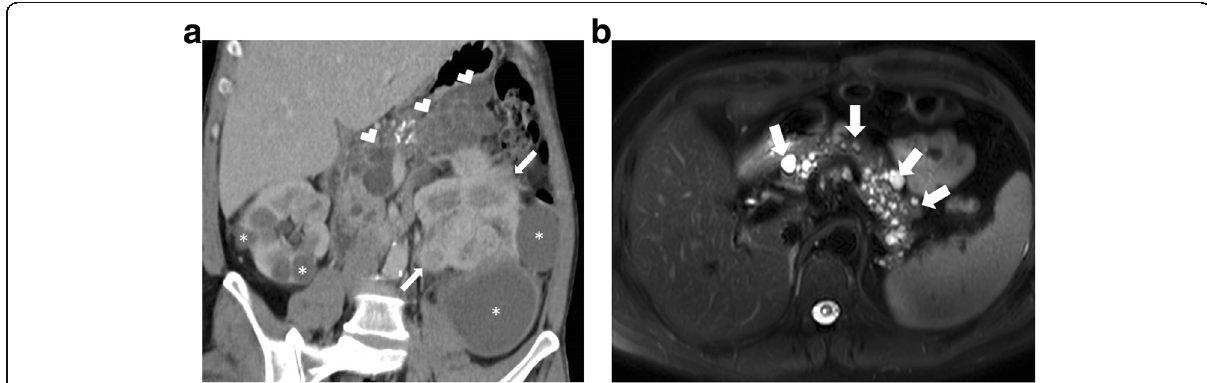
Fig. 23 Two different patients with VHL. a Coronal plane post-contrast CT image of a 47-year-old male patient shows innumerable pancreatic cysts (arrowheads). Also note is made of large-sized solid RCC (arrows) in the left kidney and bilateral renal cysts (asterisks). b Axial plane T2W MR image of a 40-year-old male patient demonstrates multiple cysts of the pancreas, almost completely replacing pancreatic parenchyma